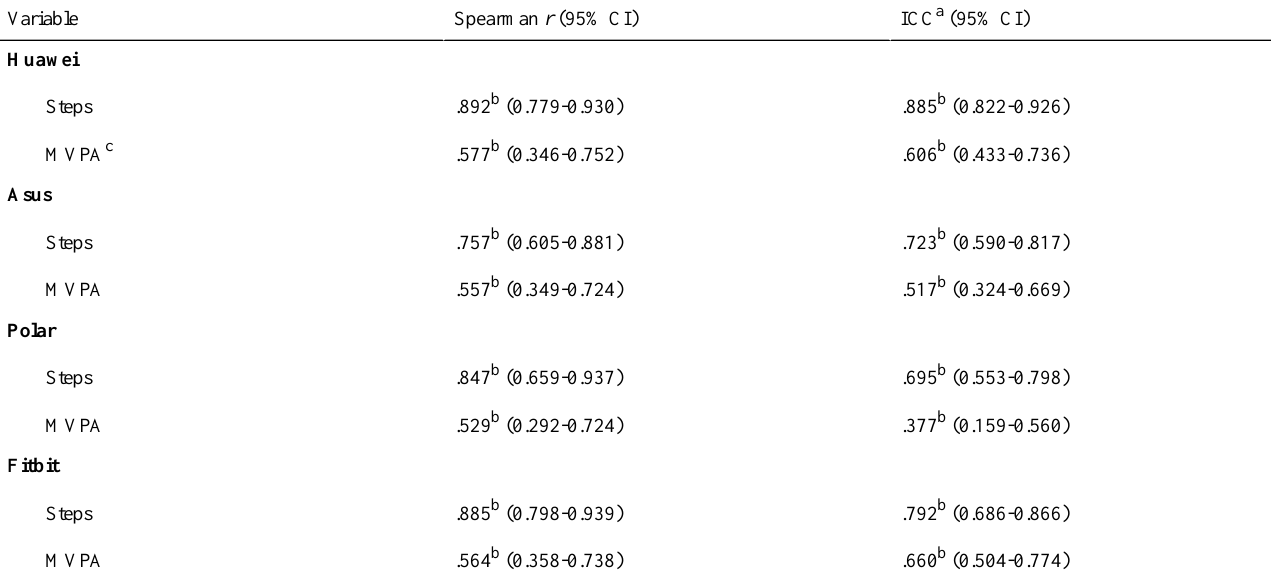
Table 3. Correlation coefficients, intraclass correlation coefficients, and 95% CI of the measurements at a day